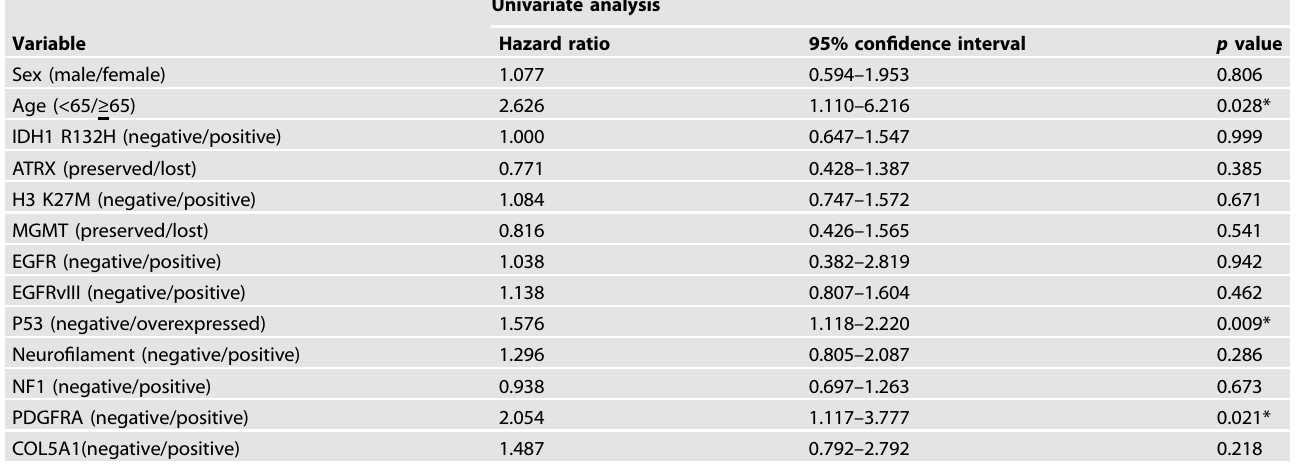
Table 1. Univariate analysis of COL5A1 expression and clinical parameters in gliomas.